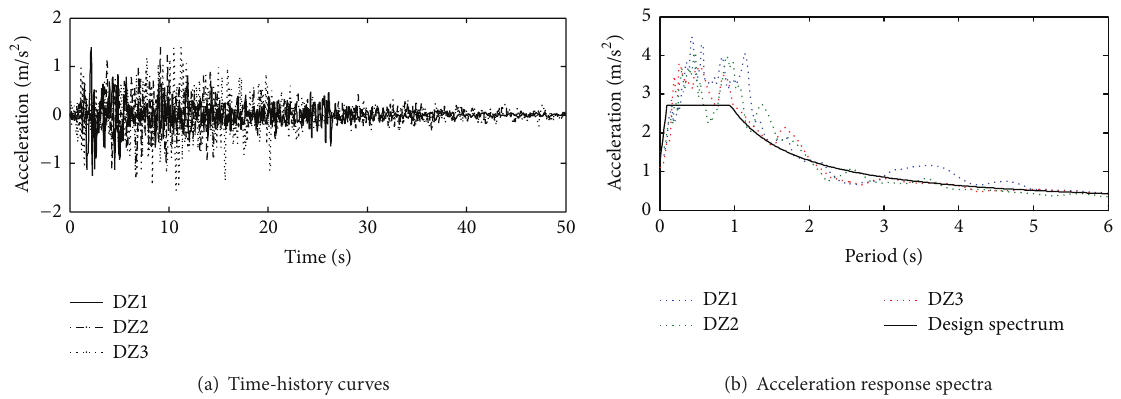
Figure 3: Time-history curves and acceleration response spectra of earthquake ground motions.